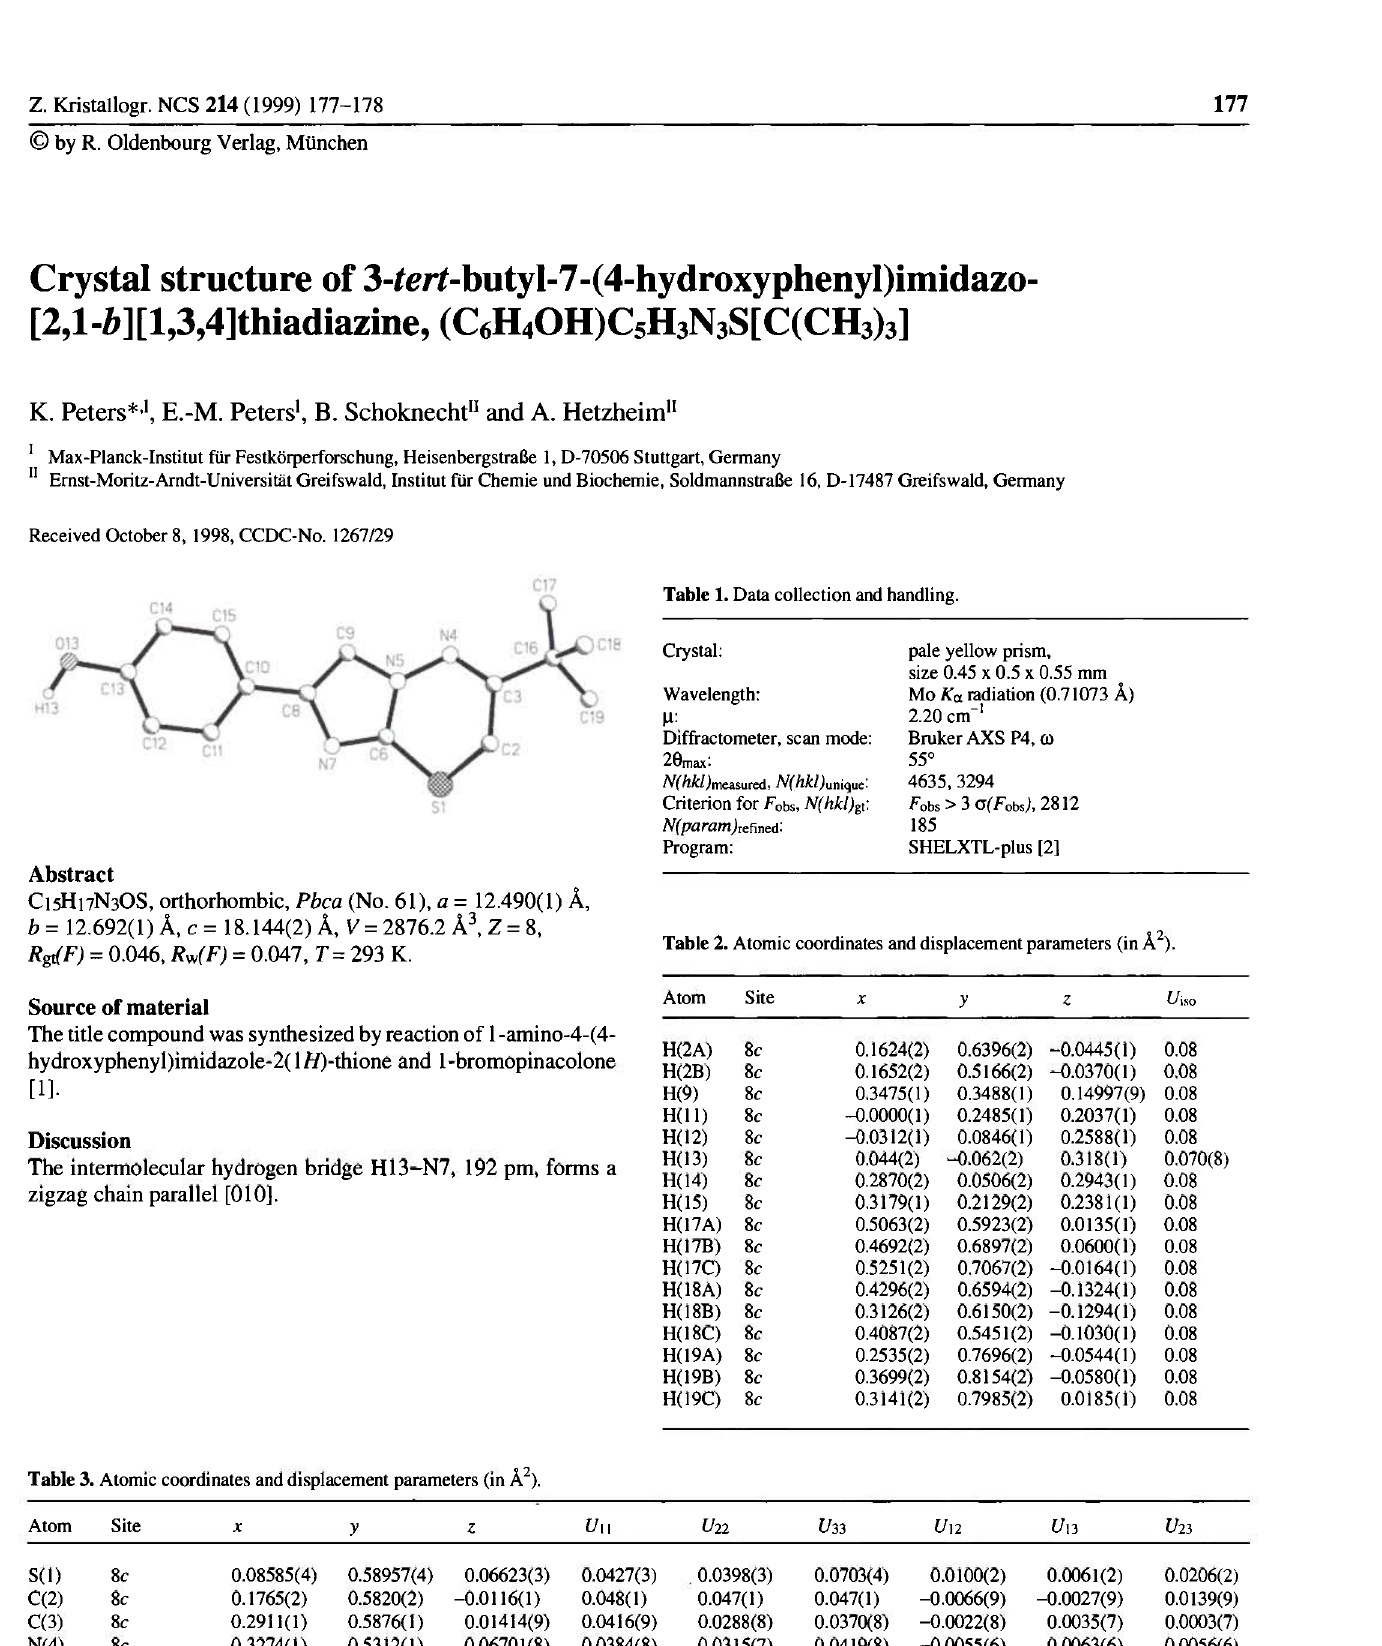
Table 3. Atomic coordinates and displacement parameters (in A 2